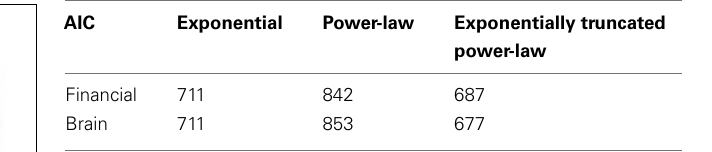
TableA1 |Akaike information criterion